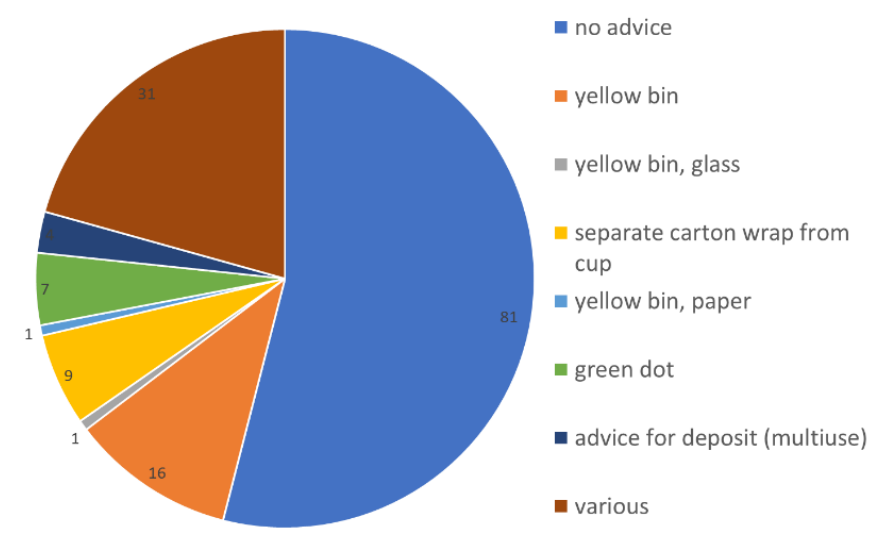
Figure 16. Recycling advice on packagings, numbers: number of samples, n = 150 .